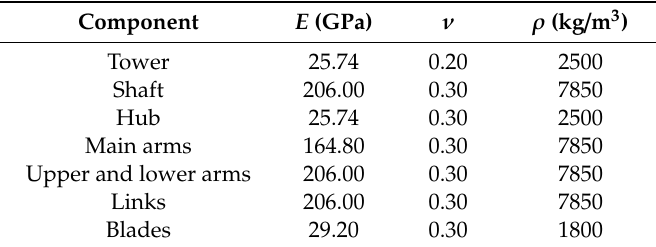
Figure 9. FE model of a straight-bladed VAWT: ( a ) FE model; ( b ) Connections. Table 3. Material properties of the components of the FE model.